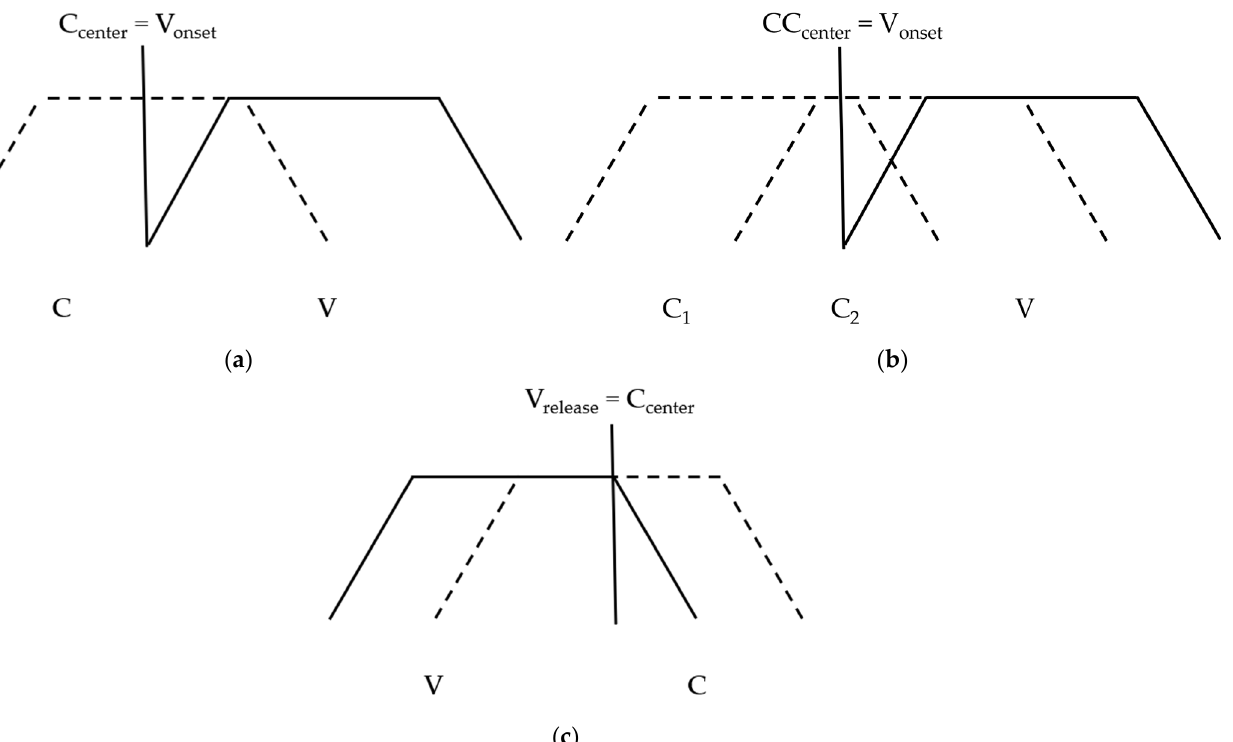
Figure 4. ( a ) CV coordination in English; ( b ) CCV (c-center) coordination in English; ( c ) VC coordination in English.